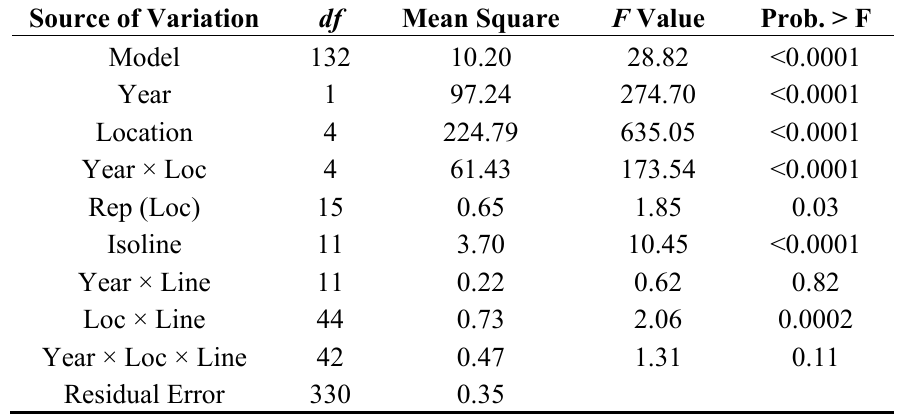
Table 2. Analysis of variance of yield of twelve isolines grown in five locations in Idaho in two